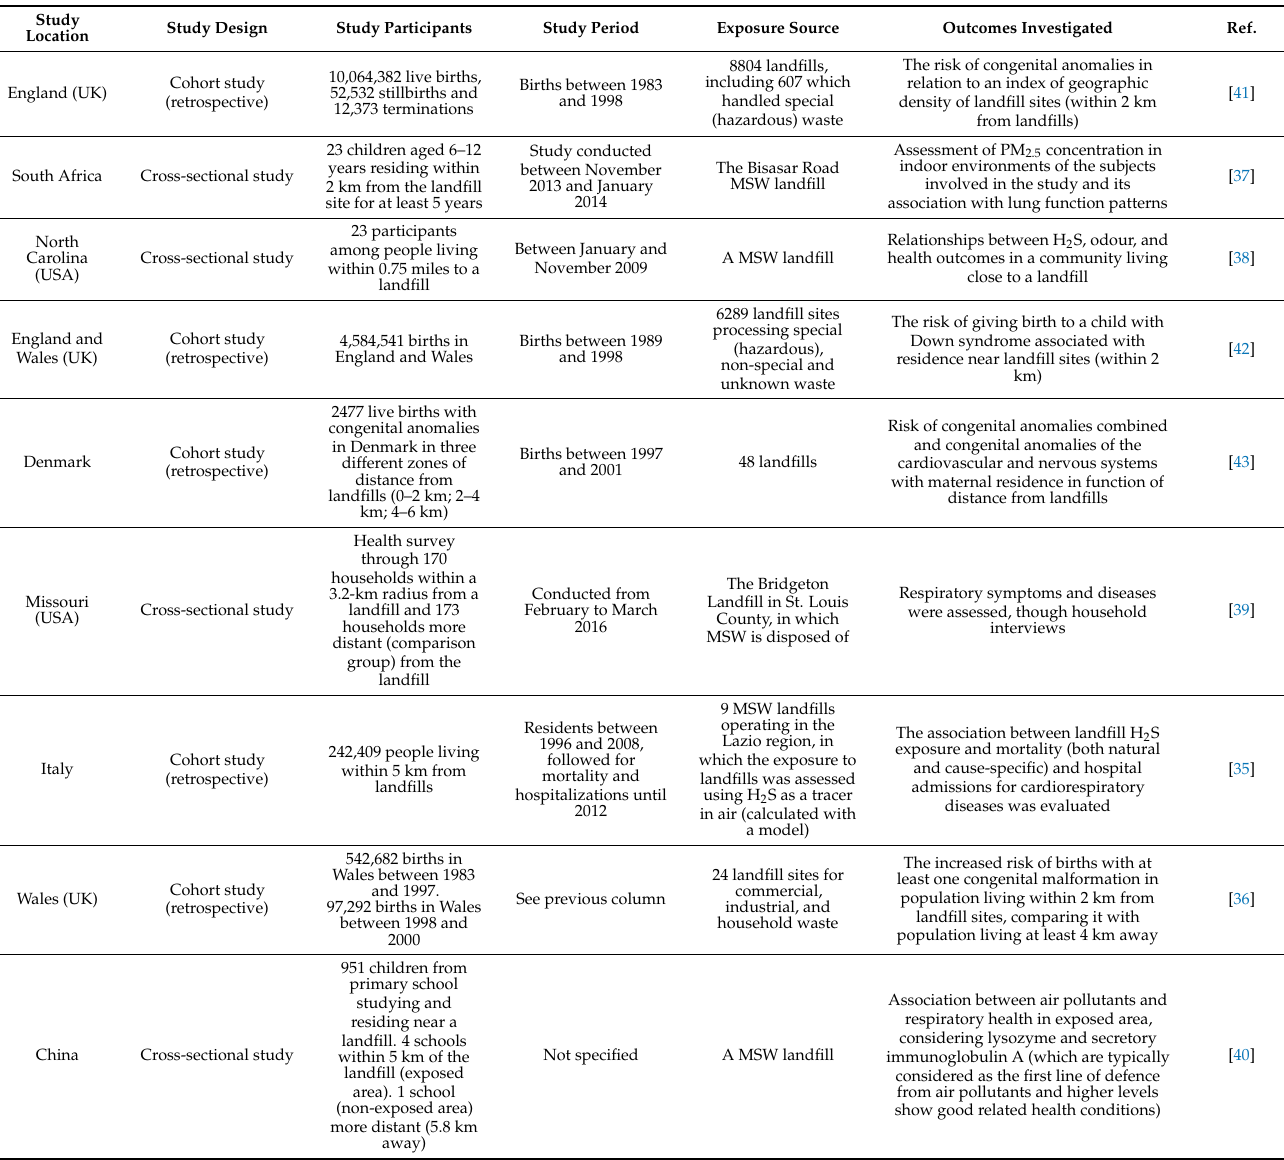
Table 1. Landfills—methodology characterizing each